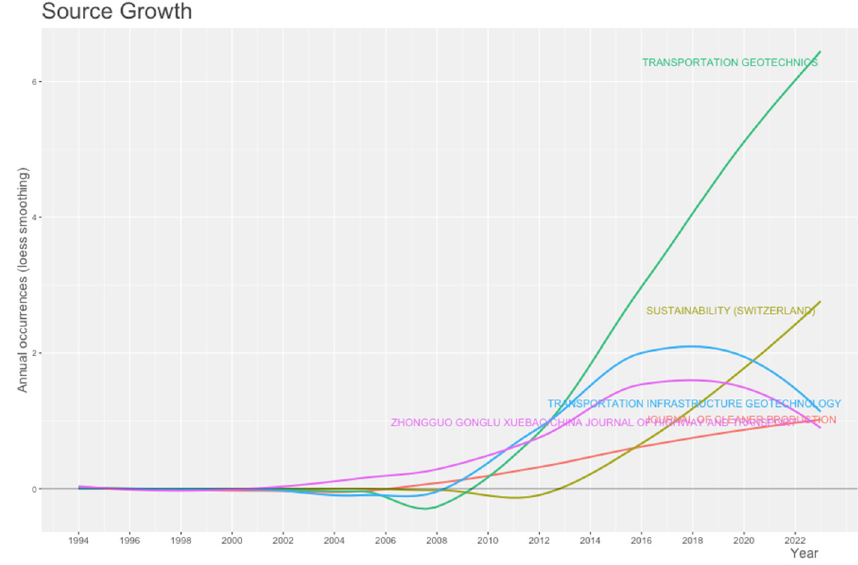
Figure 15. Source dynamics per year.